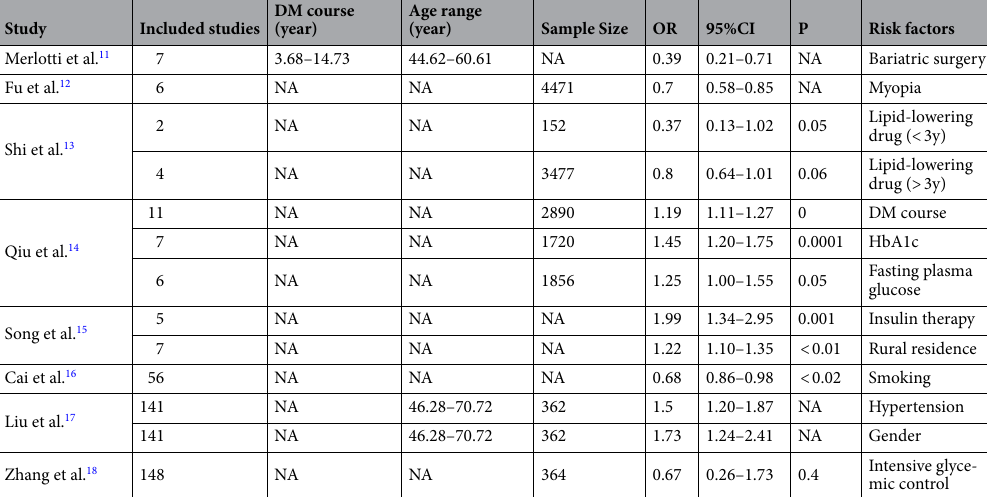
Table 1. The characteristics of the included